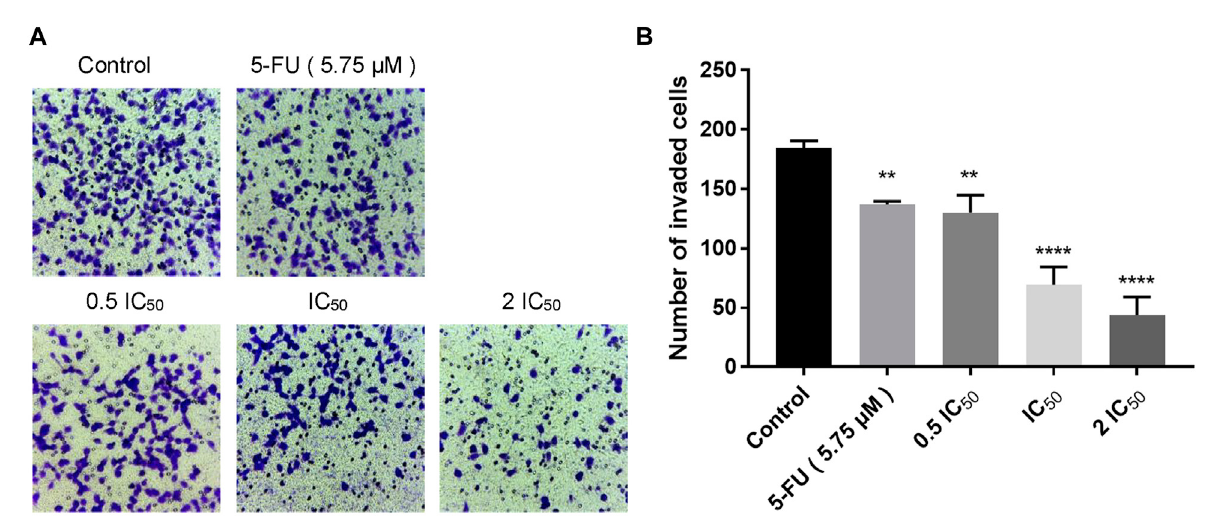
FIGURE 4 Compound 6e inhibited invasion of KB cells. (A) Microscope images of the KB cells that invaded through the matrigel after treatment of compound 6e . (B) Quanti fi cation of the cell invasion results ( n > 3). **** ( p < 0.0001), *** ( p < 0.001), ** ( p < 0.01), * ( p < 0.05), ns (not signi fi cant).